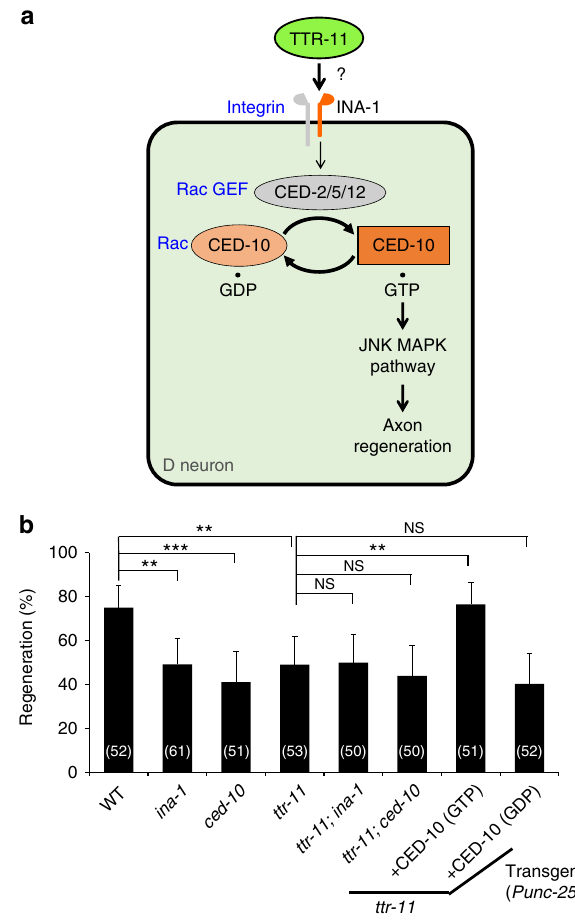
Fig. 3 TTR-11 functions in the INA-1 – CED-10 pathway. a Schematic diagram of the INA-1 – CED-10 pathway regulating axon regeneration. GEF GDP-GTP exchange factor, CED-10(GTP) GTP-binding form of CED-10, and CED-10 (GDP) GDP-binding form of CED-10. b Percentages of axons that initiated regeneration 24 h after laser surgery in the L4 stage. The number ( n ) of axons examined are shown. Error bars indicate 95% CI. ** P < 0.01, *** P < 0.001 as determined by Fisher ’ s exact test. NS: not signi fi